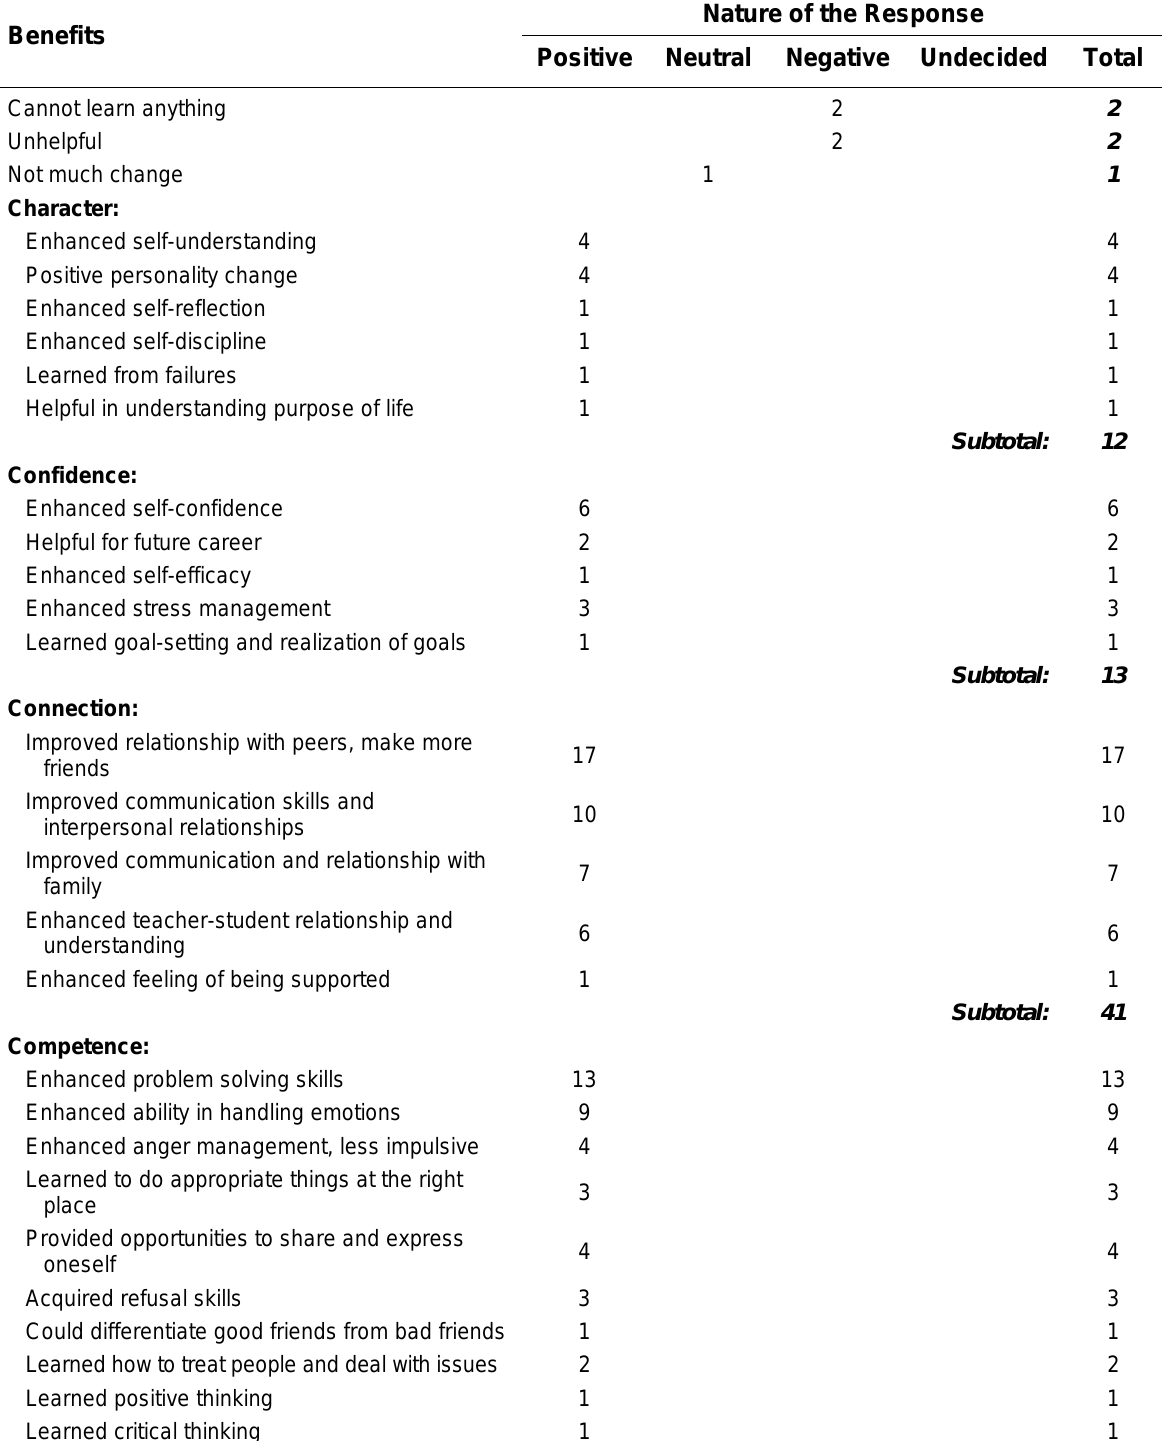
Categorization of Responses on the Perceived Benefits of and Things Learned in the Program